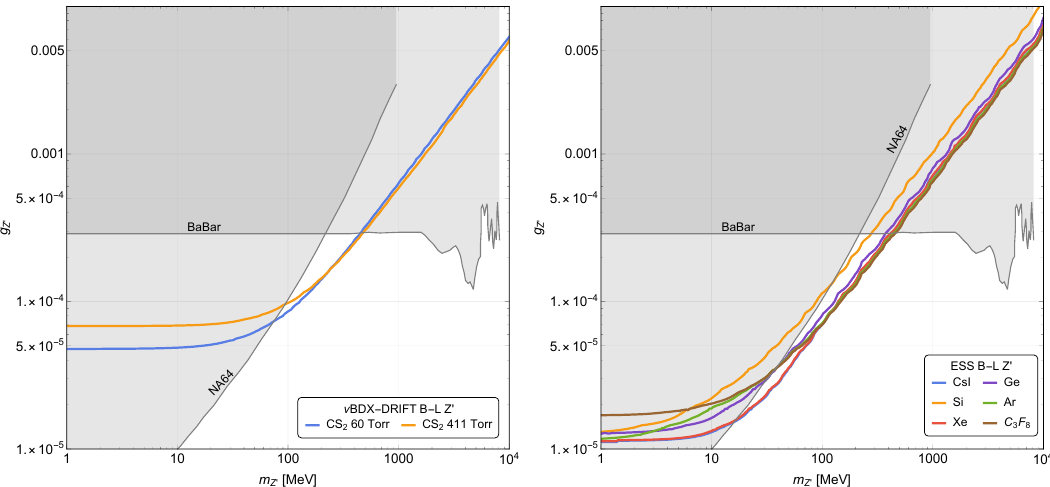
Figure 4. Future sensitivity at 90% C.L. in the m Z 0 − g Z 0 plane for the B − L model for the ν BDX- DRIFT detector (left) exploiting CS 2 at two different pressures, and the various detectors described in the text at the ESS (right). The gray shaded areas are excluded at 90% C.L. by BaBar [36] and NA64 [37, 38] assuming that the Z 0 decays dominantly in invisible dark sector states.